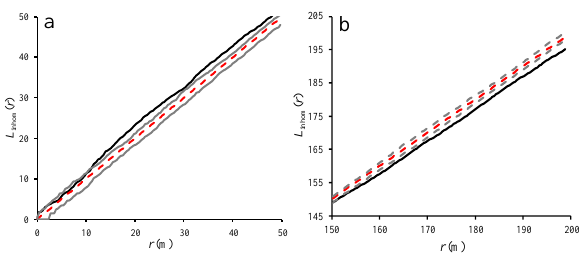
Figure 7. Inhomogeneous L -function at scales of 0-50 m (a) and 150-200 m (b) for heterogeneous pattern of wild pistachio trees.